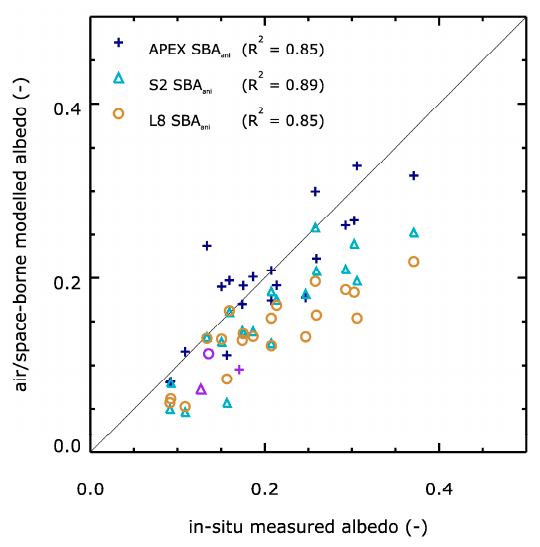
Figure 8. Comparison of observed point albedo values for Glacier de la Plaine Morte to albedo derived from airborne and satellite data using the SBA ani approach. The blue, turquoise and light brown symbols are albedometer (CM7B) measurements, whereas the purple symbols refer to the net radiometer (CNR4) measurements at the AWS.